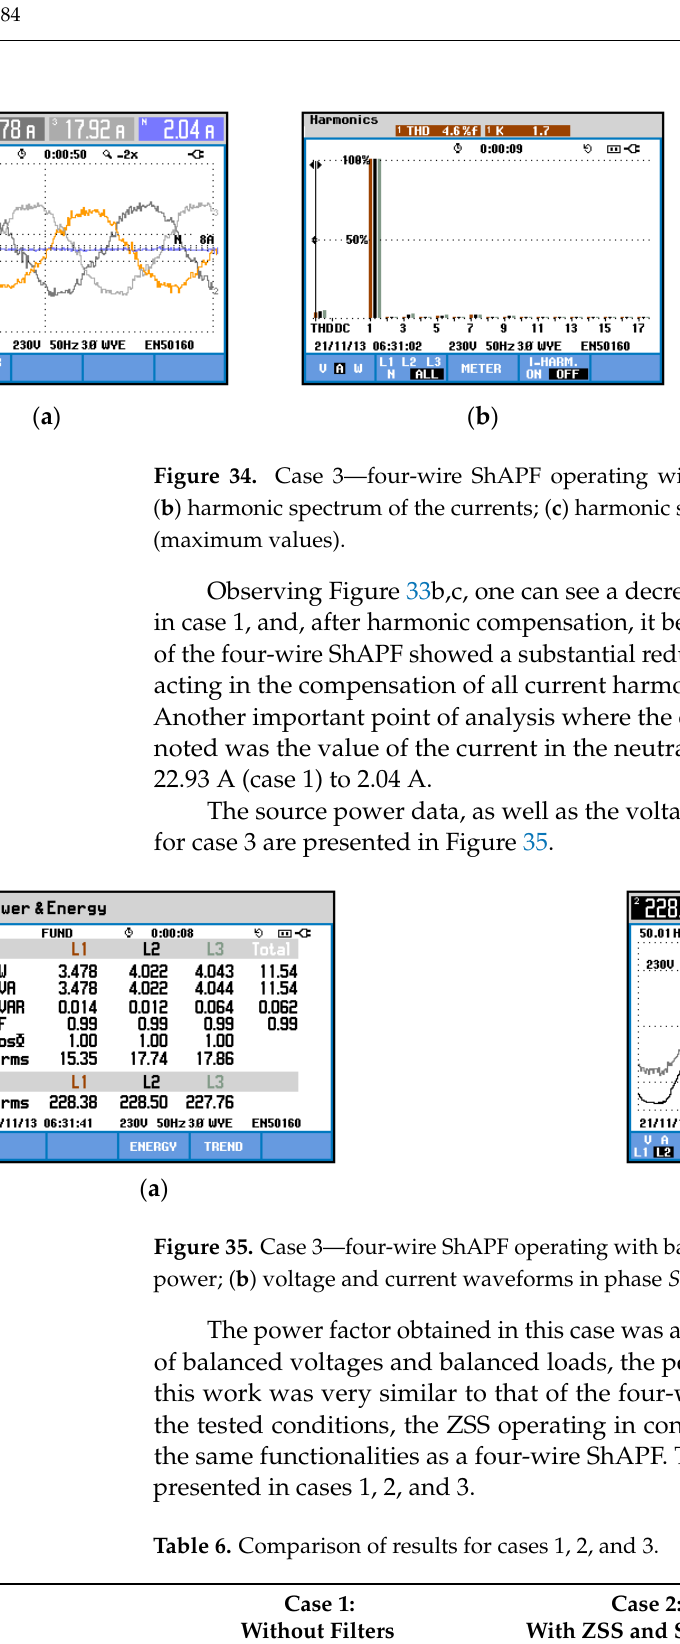
( b ) ( c ) Figure 32. Measurements in the ZSF: ( a ) three-phase currents; ( b ) harmonic spectrum of the currents; ( c ) harmonic spectrum of the current sequence components (maximum values). As expected, the ZSS provided a low-impedance path for the zero-sequence harmonics to flow along. Thus, from the point of view of harmonic mitigation, this meant that, under balanced operating conditions, all triplen harmonics were filtered by this device. On the other hand, a high positive sequence impedance was foreseen in the design of the ZSS, which also imposed some positive and/or negative sequence residual component circulating by the device. III.